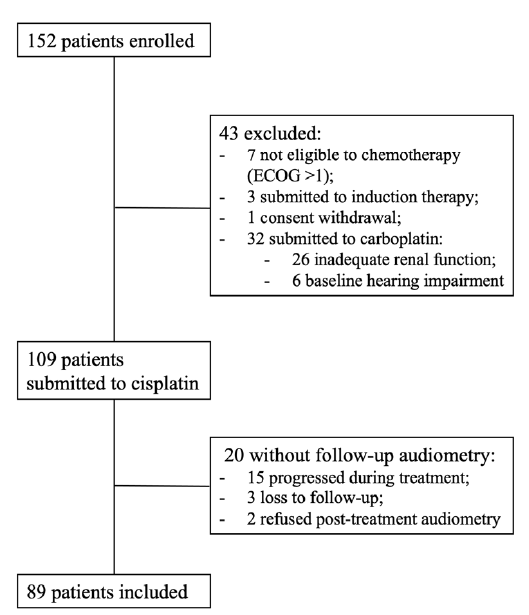
Figure 2. CONSORT diagram for patient selection. ECOG : Eastern Cooperative Oncology Group performance status.